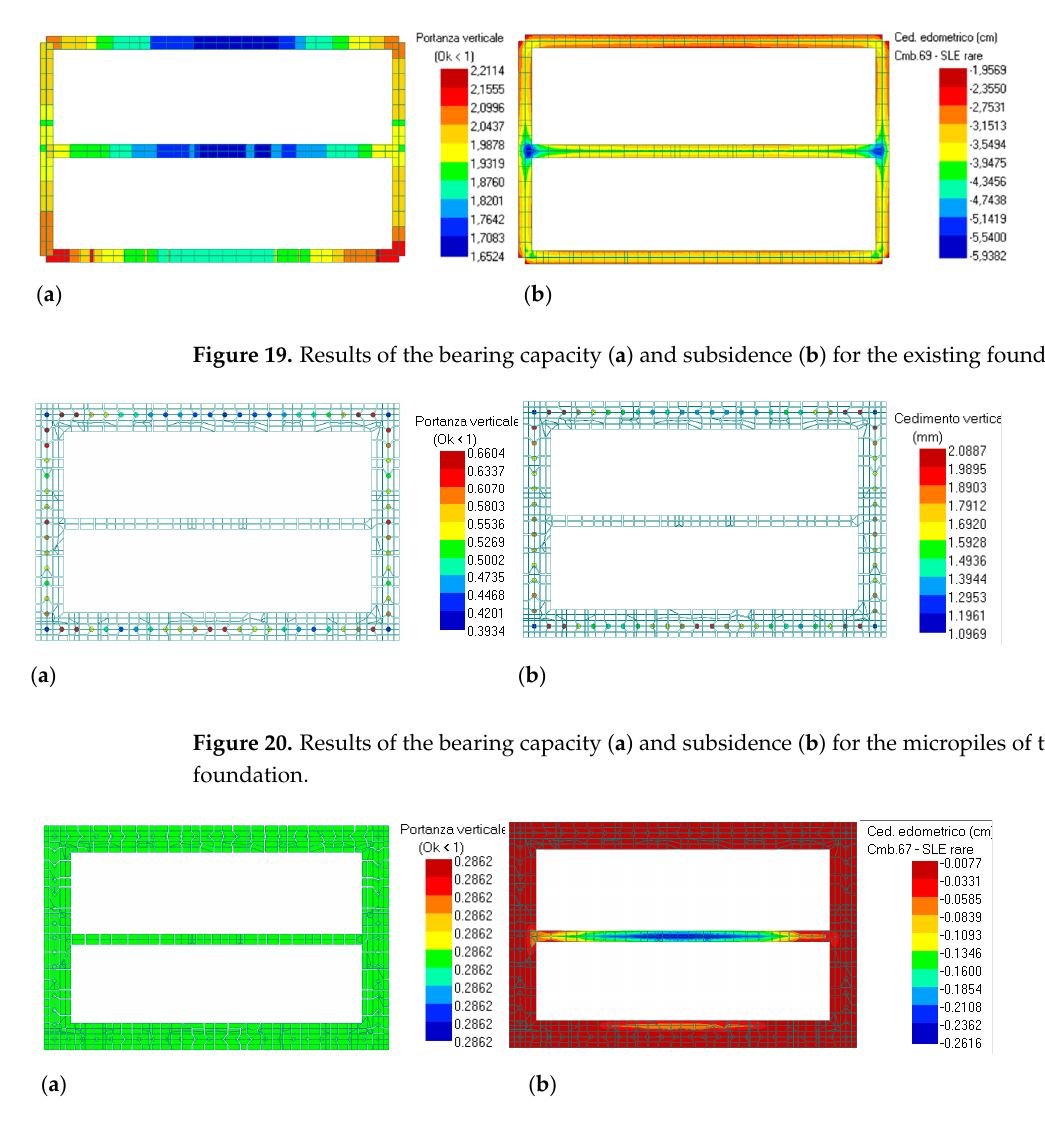
Figure 21. Outcomes of the bearing capacity ( a ) and subsidence ( b ) for the beams of the reinforced foundation.